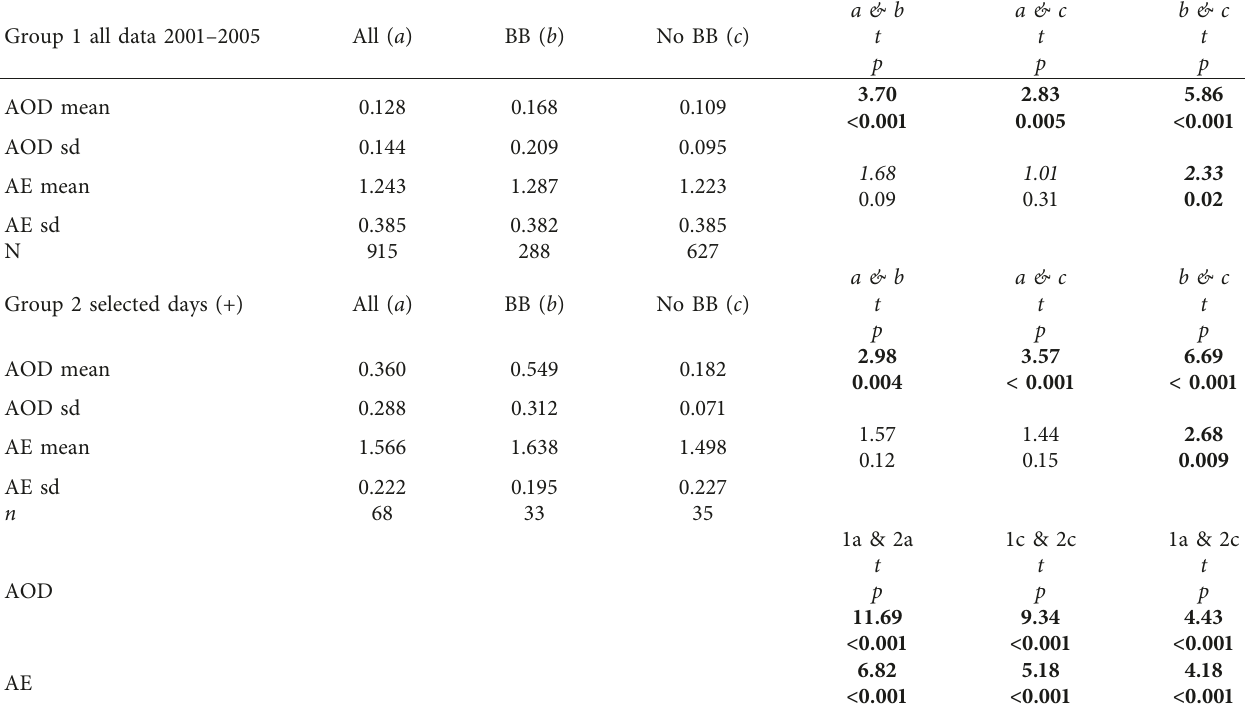
For each group and parameter, the first column presents the results for the whole data set (all) and the second and third columns correspond to the biomass- burning season (BB) and no-burning period (no BB) for each subgroup. The t and p values are the statistical variables of the t -test. Statistically significant differences (95% confidence level) between groups are highlighted in